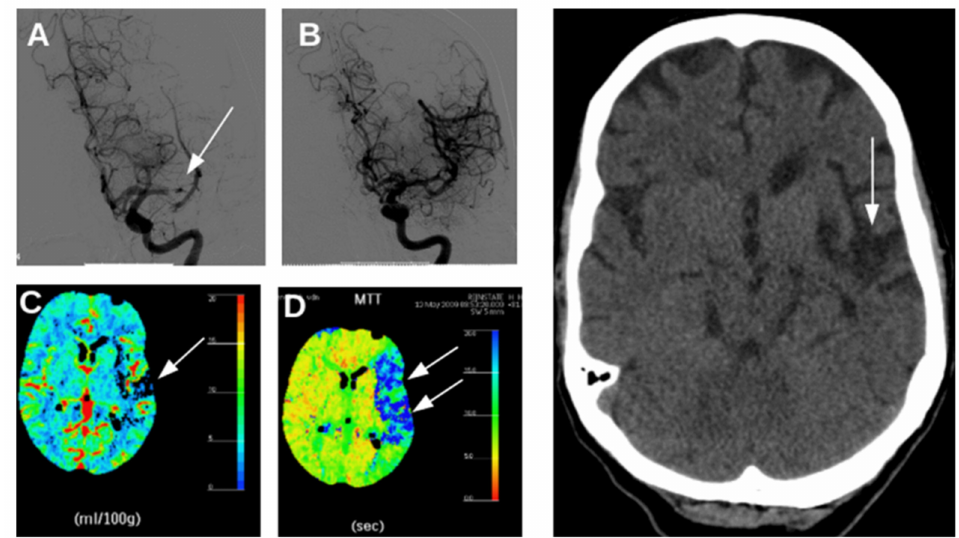
Figure 1. Radiology images from a patient with an acute ischemic stroke caused by occlusion of the left middle cerebral artery. ( A ): Digital subtraction angiography at 3 h after symptom onset obtained by intra-arterial administration of contrast agent, conforming middle cerebral artery occlusion. ( B ): revascularization after mechanical thrombectomy. ( C ): CT-perfusion maps, showing reduced cerebral blood volume (CBV) in a small part of the left hemisphere reflecting the infarct core (arrow) and ( D ) prolonged mean transit time (MTT) in a large part of the left hemisphere (blue tones in right panel, white arrows) reflecting hypoperfusion in the penumbra. Right: CT scan of the head 3 months after thrombectomy, showing a remaining lesion at the side of the previous infarct core (arrow), but recovery of brain areas that were part of the penumbra. The patient recovered